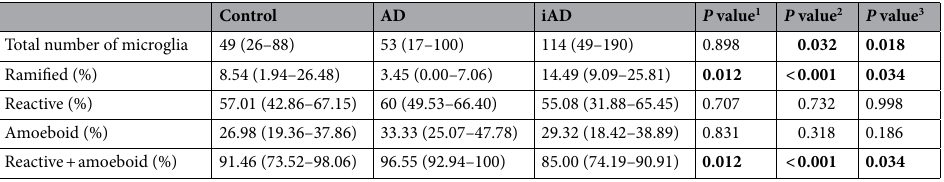
Table 1. Distribution of the proportion of each morphological category (%) in controls, AD and immunised AD groups. Values are median with IQR. P value by Kruskal–Wallis test with Benjamini–Hochberg correction for multiple testing. P value 1 : control vs. AD; P value 2 : AD vs. iAD. P value 3 : Control vs. iAD. Significant P value in bold.